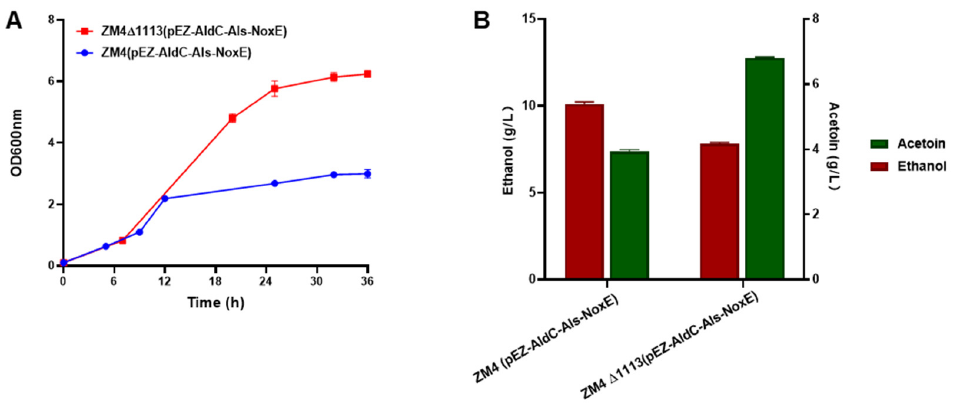
Figure 6. Growth curve ( A ) as well as the titers of ethanol and acetoin ( B ) of the recombinant strain ZM4 (pEZ-AldC-Als-NoxE) and ZM4 ∆ 1113(pEZ-AldC-Als-NoxE) cultured in flasks with the shaking speed of 200 rpm. Values are the means of experiments with three or more technical replicates, error bars are standard deviation.